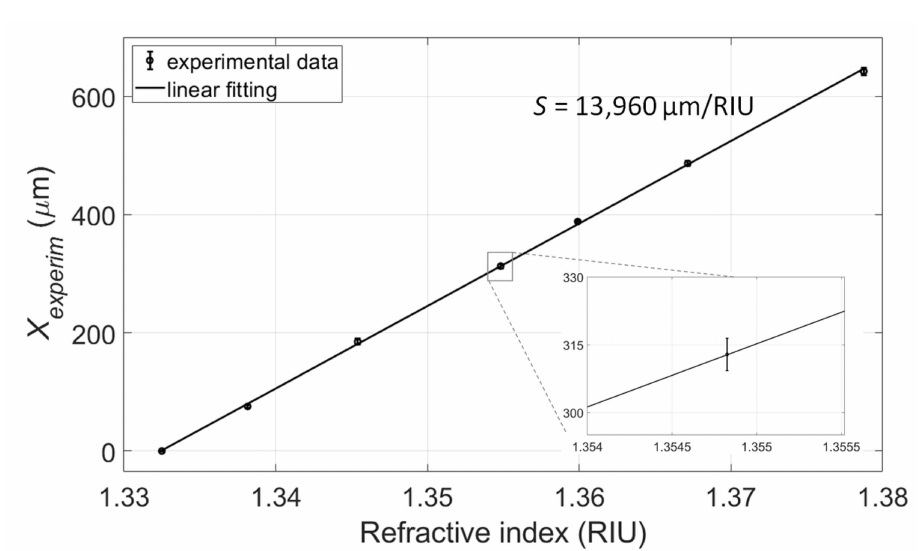
Figure 5. Linear calibration curve of the sensor obtained by fitting the values of X experim as a function of the